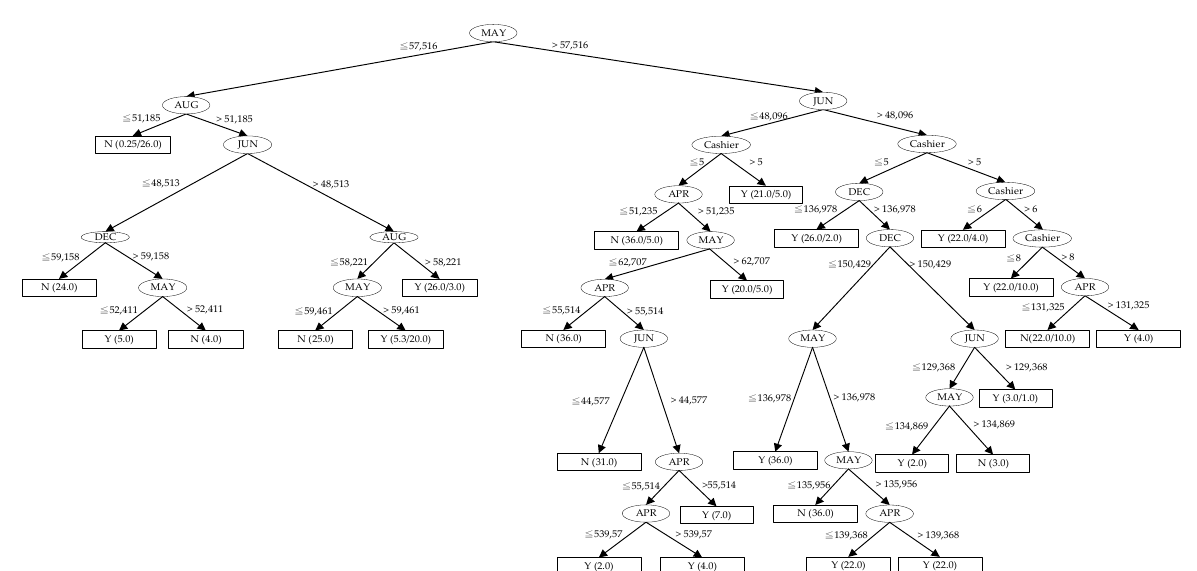
Figure 4. Model A2 J48 tree. Rule description: